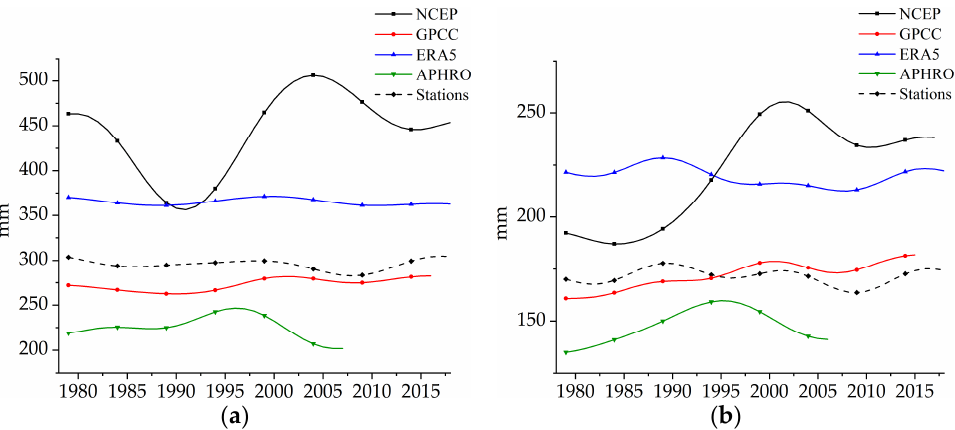
Figure 2. The interannual variability of the precipitation median values smoothed with LPF: ( a ) warm season and ( b ) cold season.